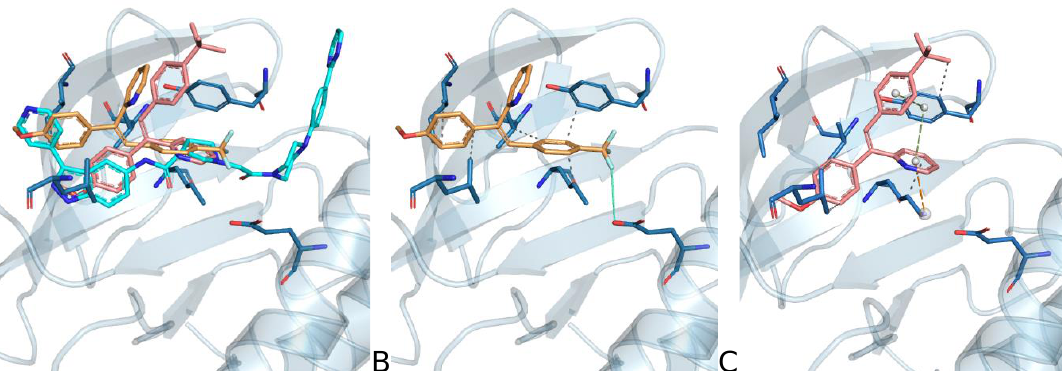
Figure 10. Predicted binding modes of compounds 12a (in orange) and 10a (in salmon) in the ERK-1 binding site (PDB ID: 4QTB) ( A ) in comparison with the 4QTB co-crystallized ligand (in cyan) and with detailed information about the interactions obtained using PLIP [53] (green dotted lines: π - stacking; orange dotted lines: π - cation interactions; grey dotted lines: hydrophobic; green line: halogen bond) and established between the ERK-1 binding site and ( B ) compounds 12a or ( C ) compound 10a.